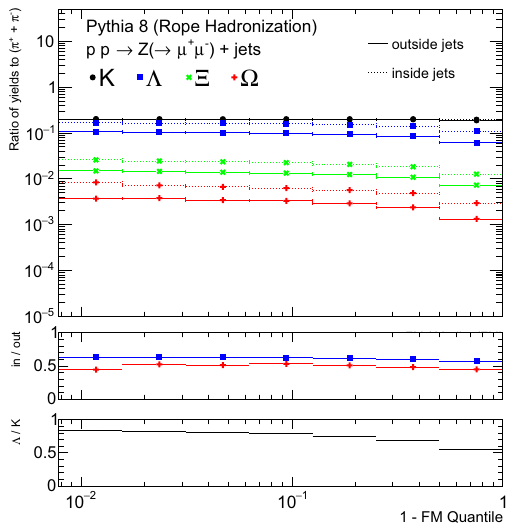
Fig. 3 The relative abundance of strange hadrons as a function of the FM quantile. Low values of the x -axis correspond to extreme mul- tiplicities; the rightmost bin captures events with multiplicities at or